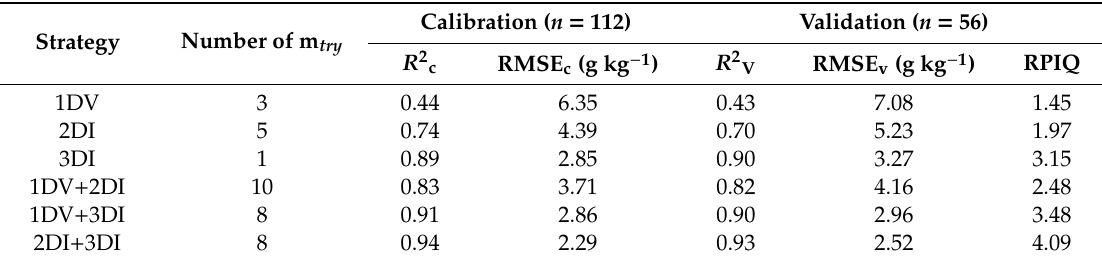
Table 4. Statistical summary of SOM developed from each strategy by using the random forest (RF)